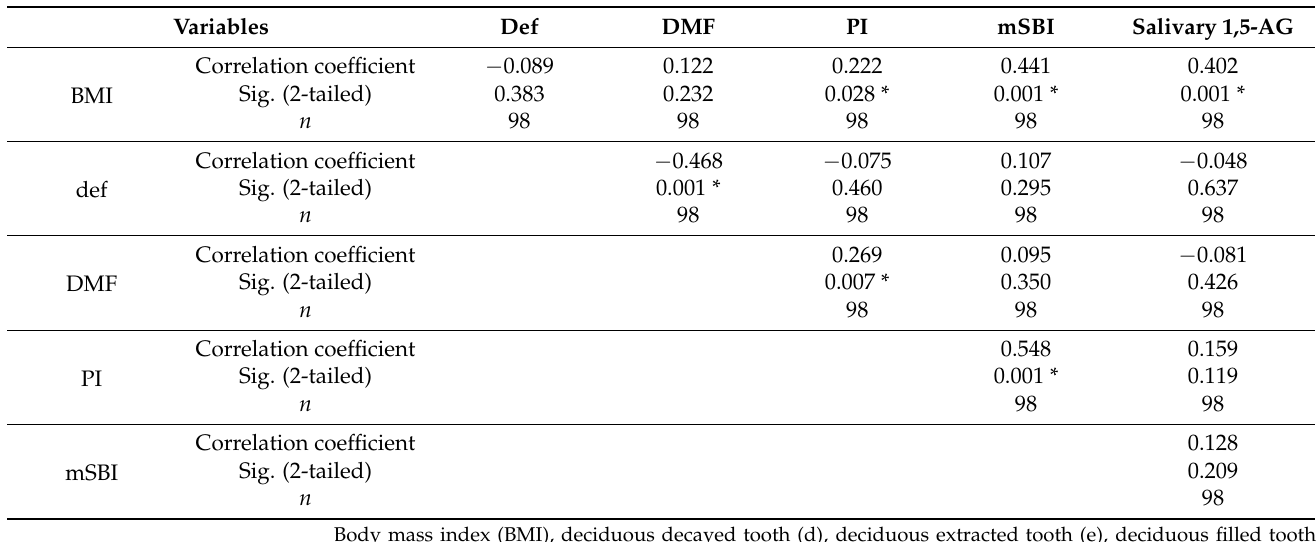
Table 4. Association between independent variables, BMI, and caries activity.